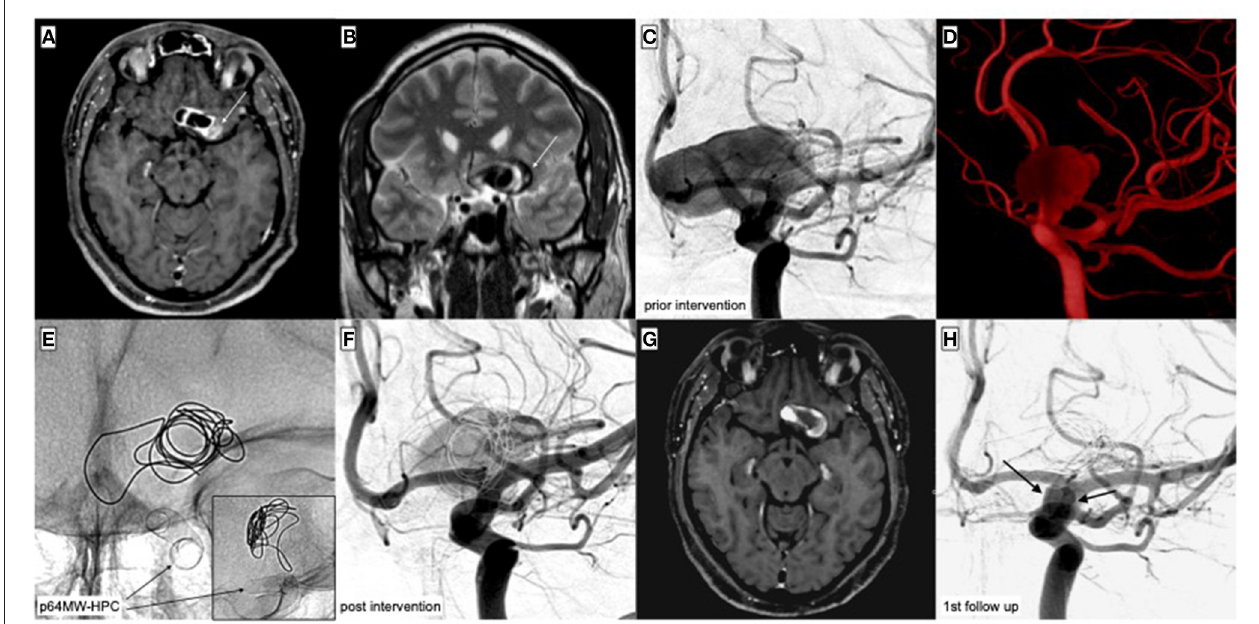
FIGURE 4 | Treatment of a partially thrombosed, giant aneurysm of the C6 segment of the left-handed side ICA. The aneurysm had compressed the ipsilateral optic nerve and caused unilateral blindness. The cause for unilateral blindness had remained unclear for months—finally, MR imaging was performed and demonstrated the underlying pathology. The decision was made for flow diversion together with loose additional coiling, in order to further decrease intra-aneurysmal flow. (A) Contrast-enhanced, axial T1-weighted imaging shows the partially thrombosed (white arrow) giant aneurysm of the left-handed side ICA. (B) Coronal T2-weighted imaging demonstrates the multi-compartmental (white arrow) aneurysm and its significant space-occupying effect. (C) DSA in posterior–anterior projection shows the 26 × 17mm perfused compartment of the aneurysm. (D) Reconstruction of the 3D rotational angiogram demonstrating the neck level of the giant aneurysm. (E) Radiography in posterior–anterior projection post implantation and coiling. The distal end of the p64MW-HPC was positioned in the C7 segment of the ICA, avoiding affection of the ICA-T. One coil was placed inside the aneurysm in order to further disrupt intra-aneurysmal flow. The image in the lower right corner displays the lateral projection after FDS implantation and supplementary coiling. (F) DSA immediately after implantation of the FDS. Note the already decreased volume of the residually perfused compartment. Compared to (C) , aneurysmal perfusion is markedly delayed. (G) Contrast-enhanced, axial T1-weighted imaging 5 weeks post procedure demonstrating the significantly decreased volume of the aneurysm together with progressive thrombosis of the peripheral compartments. (H) First angiographic follow-up in posterior–anterior projection 3 months post intervention. The aneurysm is sufficiently separated from the parent vessel (OKM